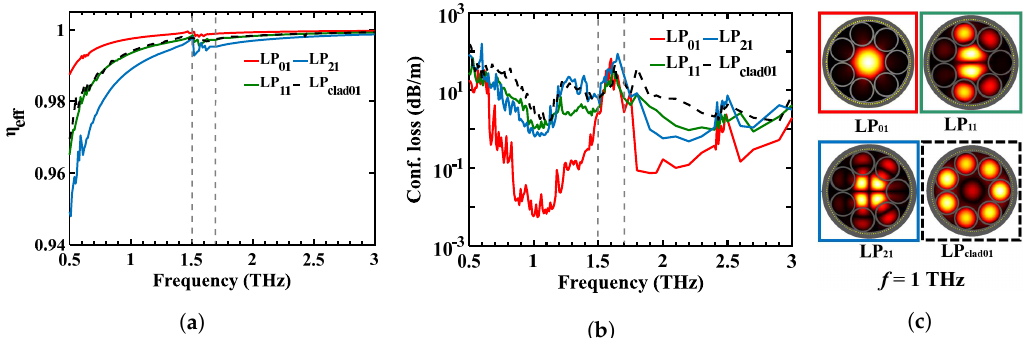
Figure 5. Simulated ( a ) η eff ; ( b ) confinement loss; and ( c ) spatial electric field E distribution of AR fiber for the LP 01 , LP 11 , LP 21 , and LP clad01 mode. The fiber has 140 metal-wire inclusions, a uniform wire diameter d = 90 µ m and fixed dielectric thickness between the internal side of the metal wire and the inner dielectric cladding layer p = 289 µ m.